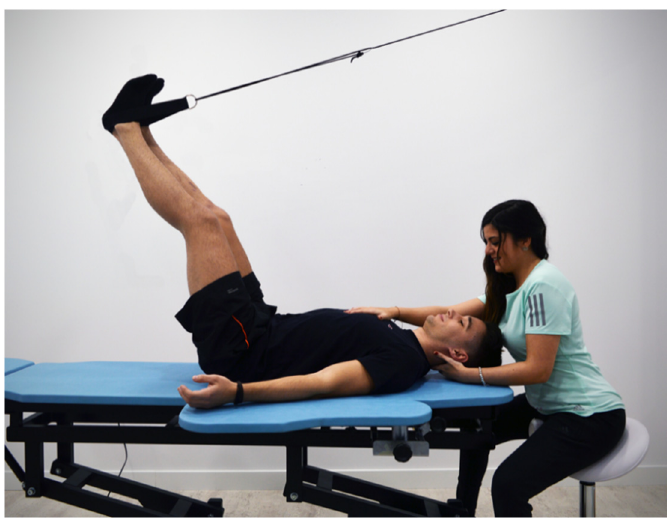
Figure 1. Example of GPR therapeutic management, with patient placed in lying position with lower limbs hanged to increase the tension in the triceps surae, hamstring muscles and gluteus maximus while asked to perform paradoxical breathing and spine corrections. The posture will evolve to increase in hip flexion.